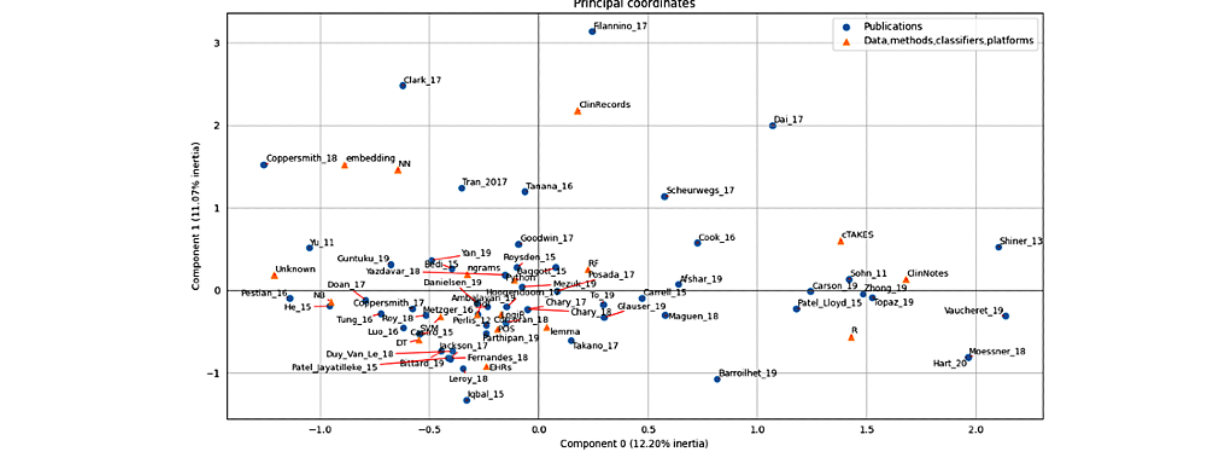
Figure 2. Correspondence